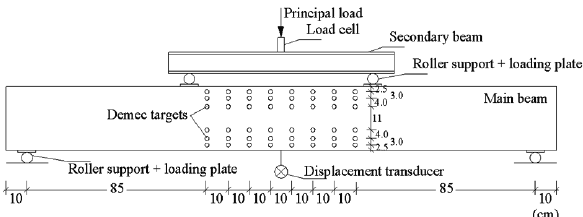
failureFig. 2. Set-up for testing beam specimen (Bernardo et al. Fig. 3. Test beam after